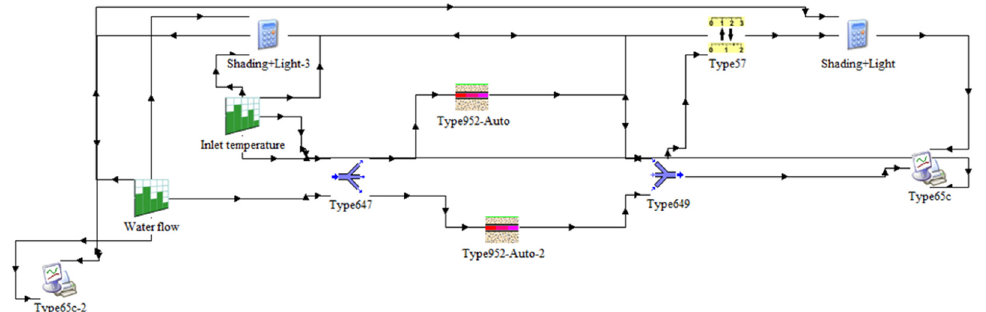
Figure 6. Simulator configuration of the geothermal heat pump to study the performance with TRNSyS 2017 under the weather conditions of the site.